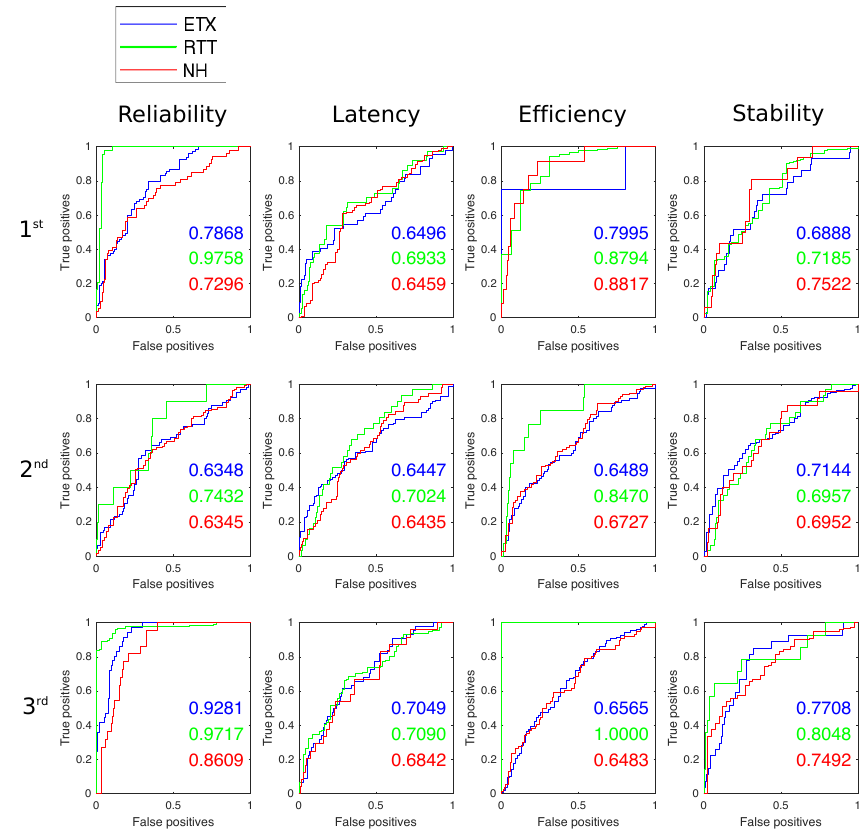
Figure 7. ROC curves including AUC value when determining the rank position for each solution for each evaluation